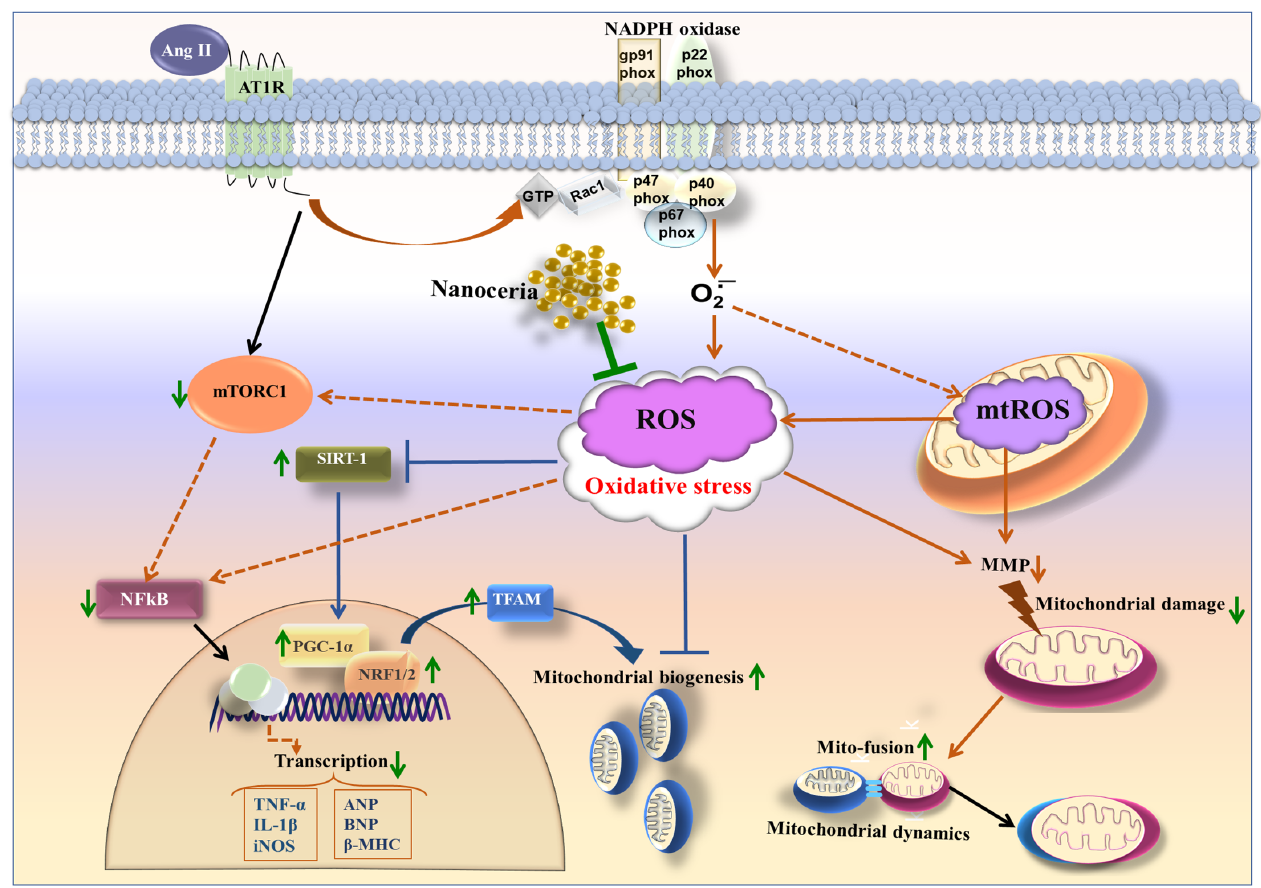
Figure 9. Schematic diagram depicting the protective e ff ects of NC (arrows in green) on Ang II- induced signaling in H9c2 cardiomyoblasts. induced signaling in H9c2